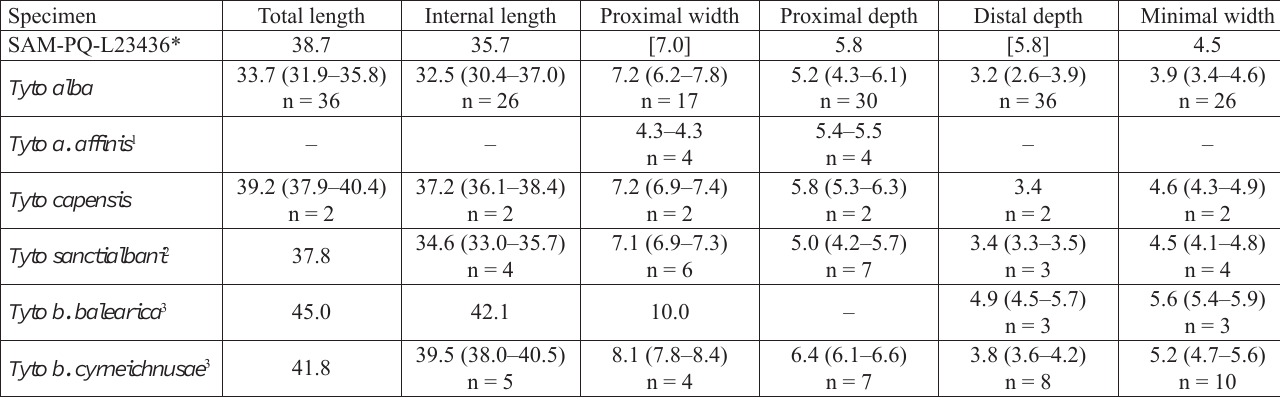
Table 1. Measurements (in mm) of the coracoid SAM-PQ-L23436 (paratype) of Tyto richae sp. nov. from Langebaanweg in comparison to corre- sponding measurements of extant T. alba and fossil Tyto species. Measurements of slightly worn or damaged bones are given in square brackets. Paratype is indicated by an asterisk; 1 measurements after Brodkorb and Mourer-Chauviré (1984); 2 measurements after Pavia and Mourer-Chau- viré (2011); 3 measurements after Louchart (2002); n, sample size.